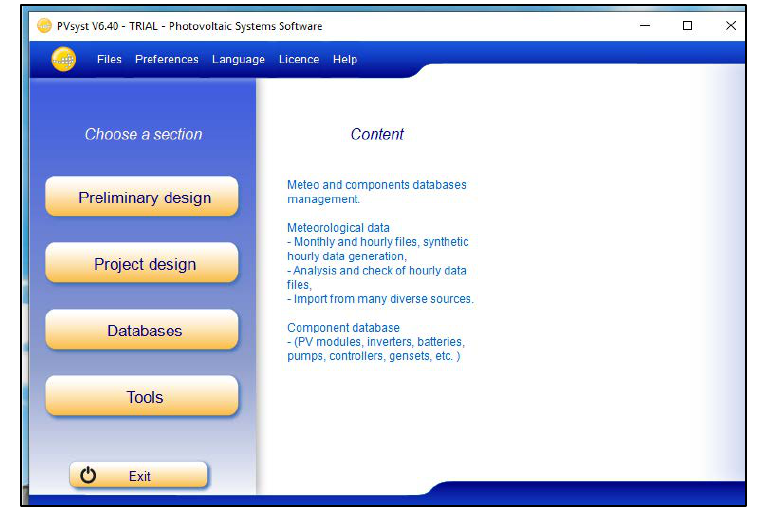
Figure 7: PVsyst V6.40 software